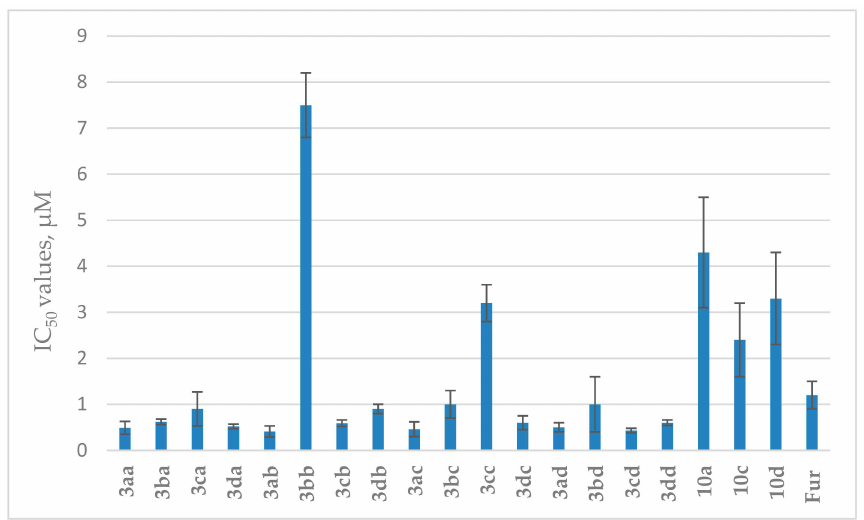
Figure 2. The Tdp1 inhibitory activities of compounds 3aa – 3dd and 10a , c , d . Furamidine (Fur) was used as a positive